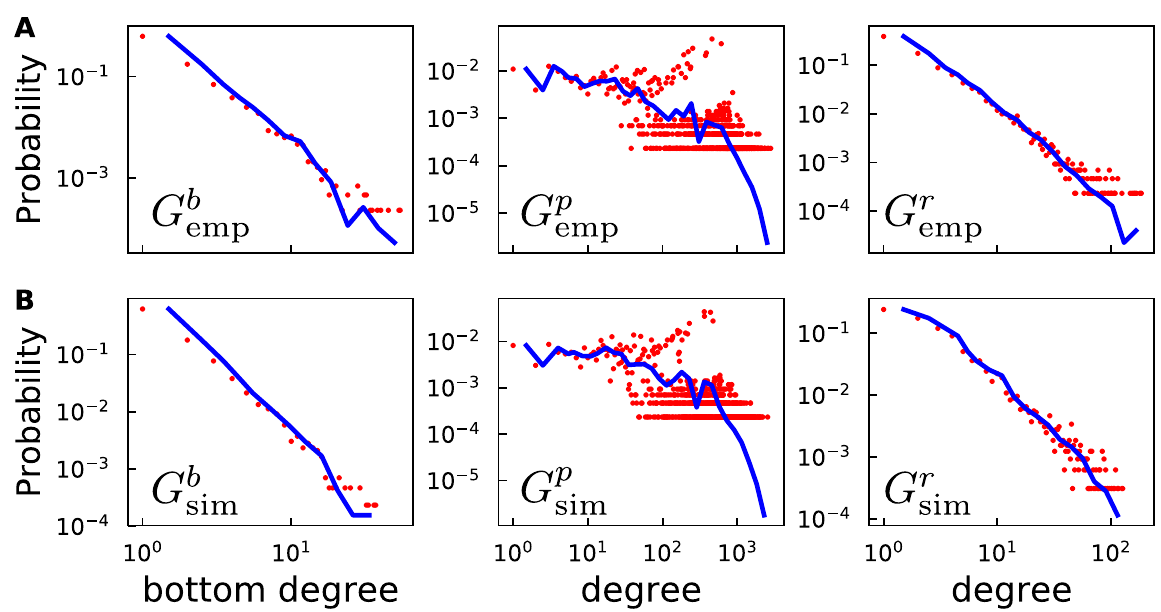
Fig 6. Degree distributions of the bipartite network G b , projection network G p and reply network G r based on empirical data (upper panel) and simulated results (lower panel). In our simulation, we set k = 2, μ = 0.5, ε = 0.5, τ = 10, and θ = 0.028 to generate G r lines are the histograms using logarithmically spaced bins